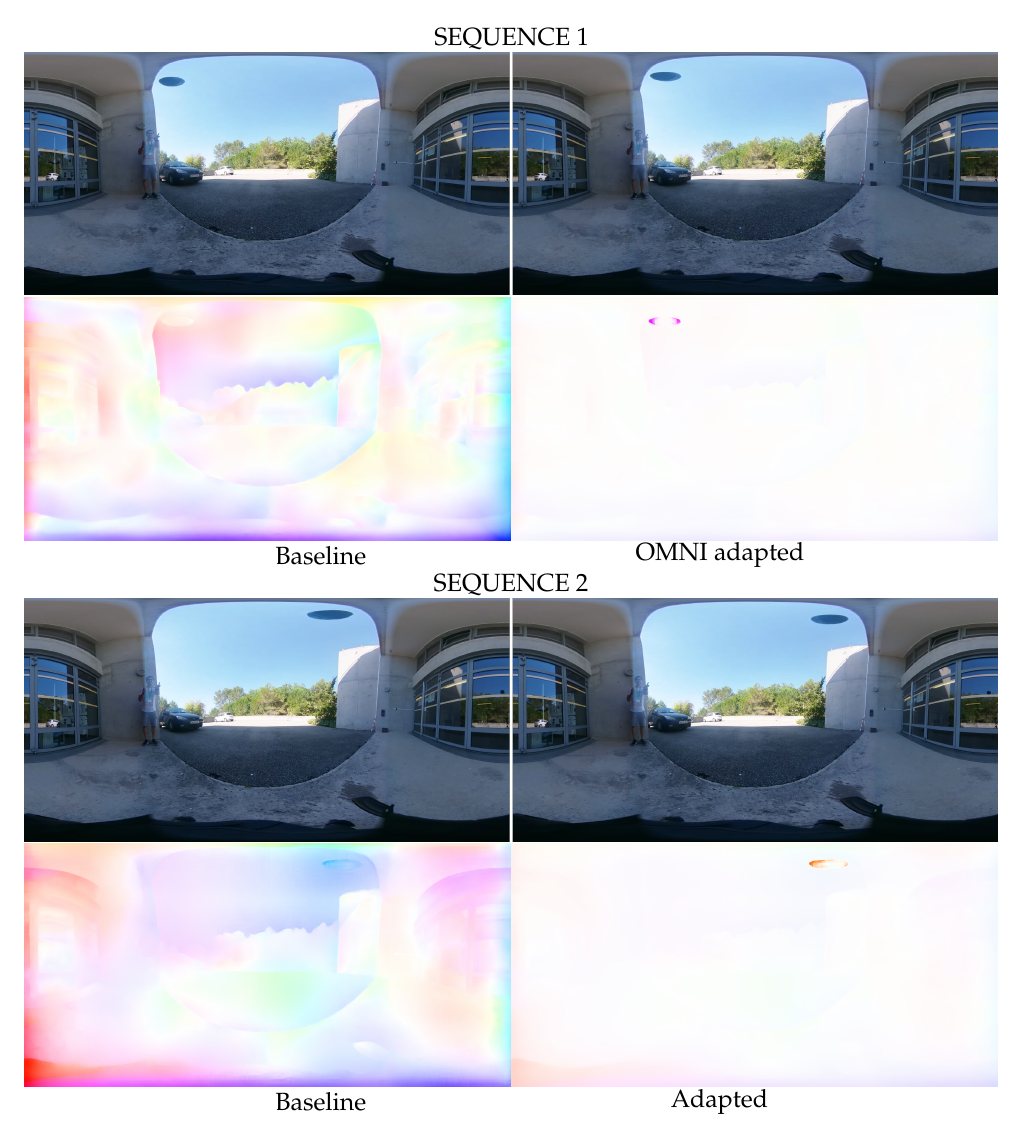
Figure 10. Ball throw example. The adapted network provides correct optical flow estimation, whereas the baseline version loses track of the ball. Top left: RGB input frame at t , top right: RGB input frame at t + 1, bottom left: prediction from the baseline network, bottom right: prediction from the adapted